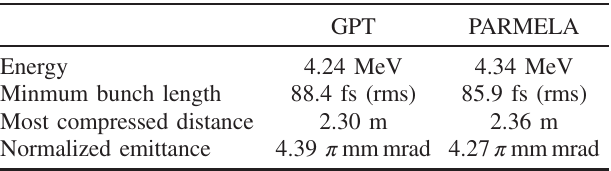
TABLE III. Results of ECC-rf gun simulation by GPT and PARMELA.